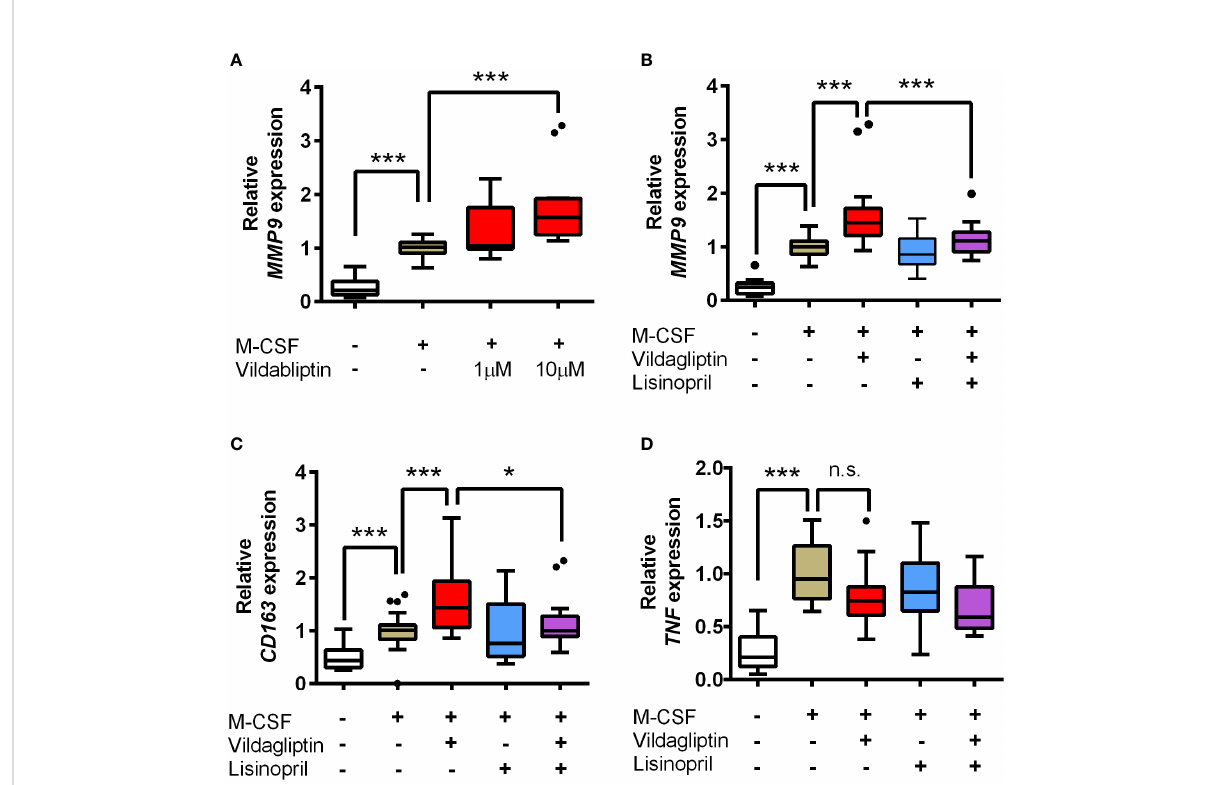
FIGURE 3 Effects of vildagliptin and lisinopril on the expression levels of MMP9 , CD163 , and TNF in human monocytes/macrophages stimulated using M- CSF. Monocytes were isolated from hPBMCs using the MACS system and were cultured for seven days in the presence or absence of each compound with or without 50 ng/mL M-CSF. mRNA levels per gene were assessed in the indicated number ( n ) of donors based on three to six replicates per donor and were normalized to GAPDH. Data are relative to the M-CSF group at a concentration of 1. (A) Concentration- dependent effects of vildagliptin (1 – 10 m mol/L) on MMP9 expression ( n = 4). (B – D) Combined effect of lisinopril (10 m mol/L) and vildagliptin (10 m mol/L) on MMP9 expression ( n = 8; *** p < 0.005), CD163 ( n = 6; * p < 0.05, *** p < 0.005), and TNF (n = 6; *** p < 0.005; n.s., not signi fi cant). Boxes indicate the 25th and 75th percentiles; lines inside the boxes indicate medians, and whiskers indicate the upper and lower adjacent values (3/2-fold the interquartile range from the end of the box) as per Tukey ’ s test. Dots represent outliers beyond the whiskers ’